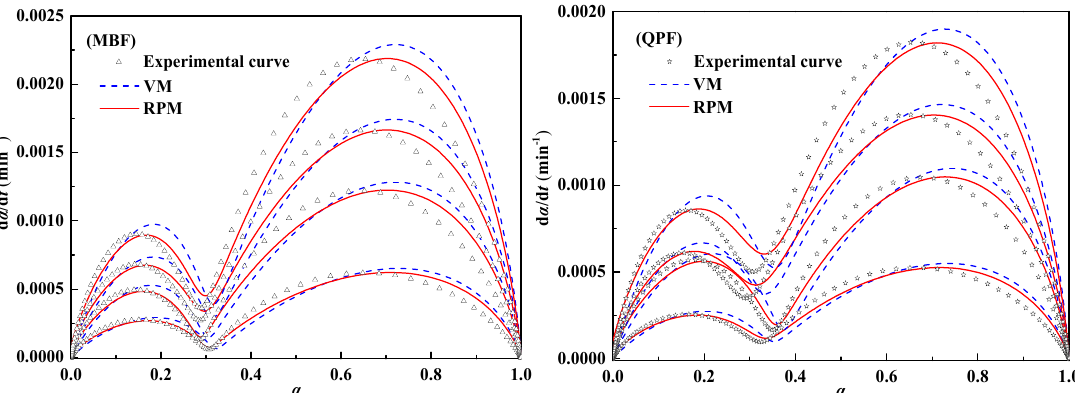
Figure 7. Combustion rates of MBF, QPF and fitting curves of double parallel reaction volume model (DVM) and double parallel random pore model (DRPM).